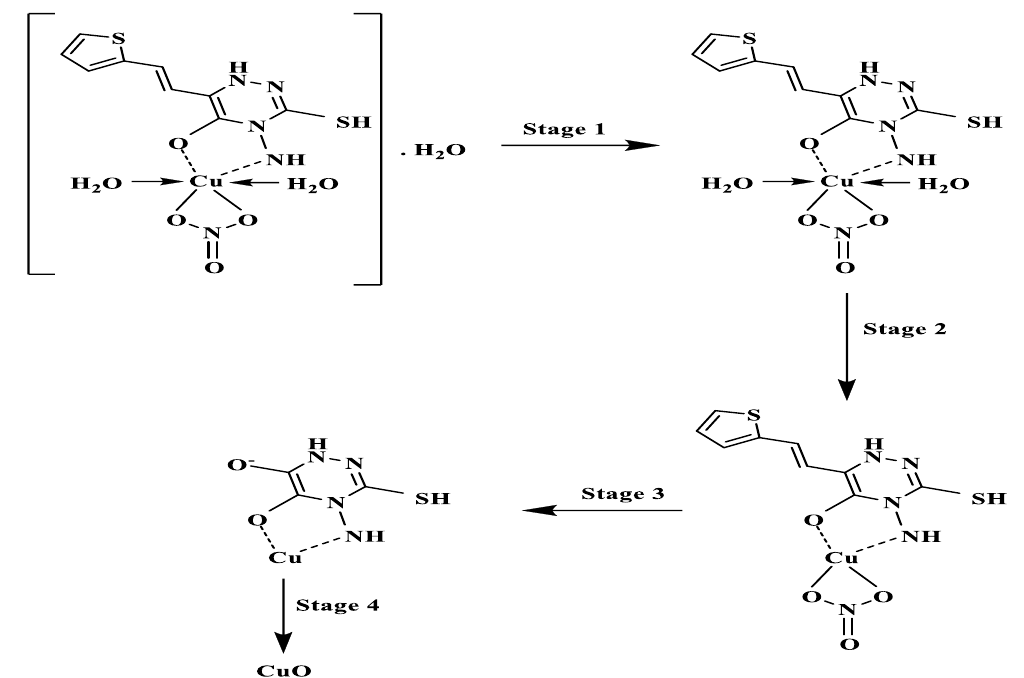
Figure 7. Electron spin resonance of [Cu(L)(NO 3 )(H 2 O) 2 ] • H 2 O. Two arrows indicate the significant Fig. ESR spectrum of Cu(II)-AMT complex. peaks in